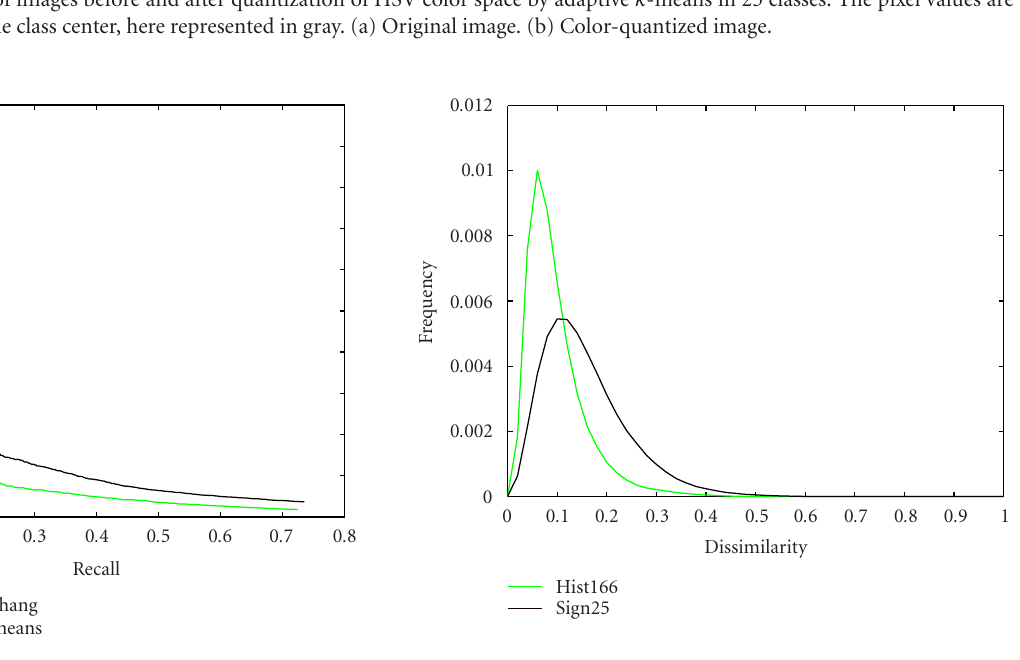
Figure 5: Capacity curves for the color histogram in 166 classes of Smith and Chang and for our color signature (color space HSV) of 25 classes